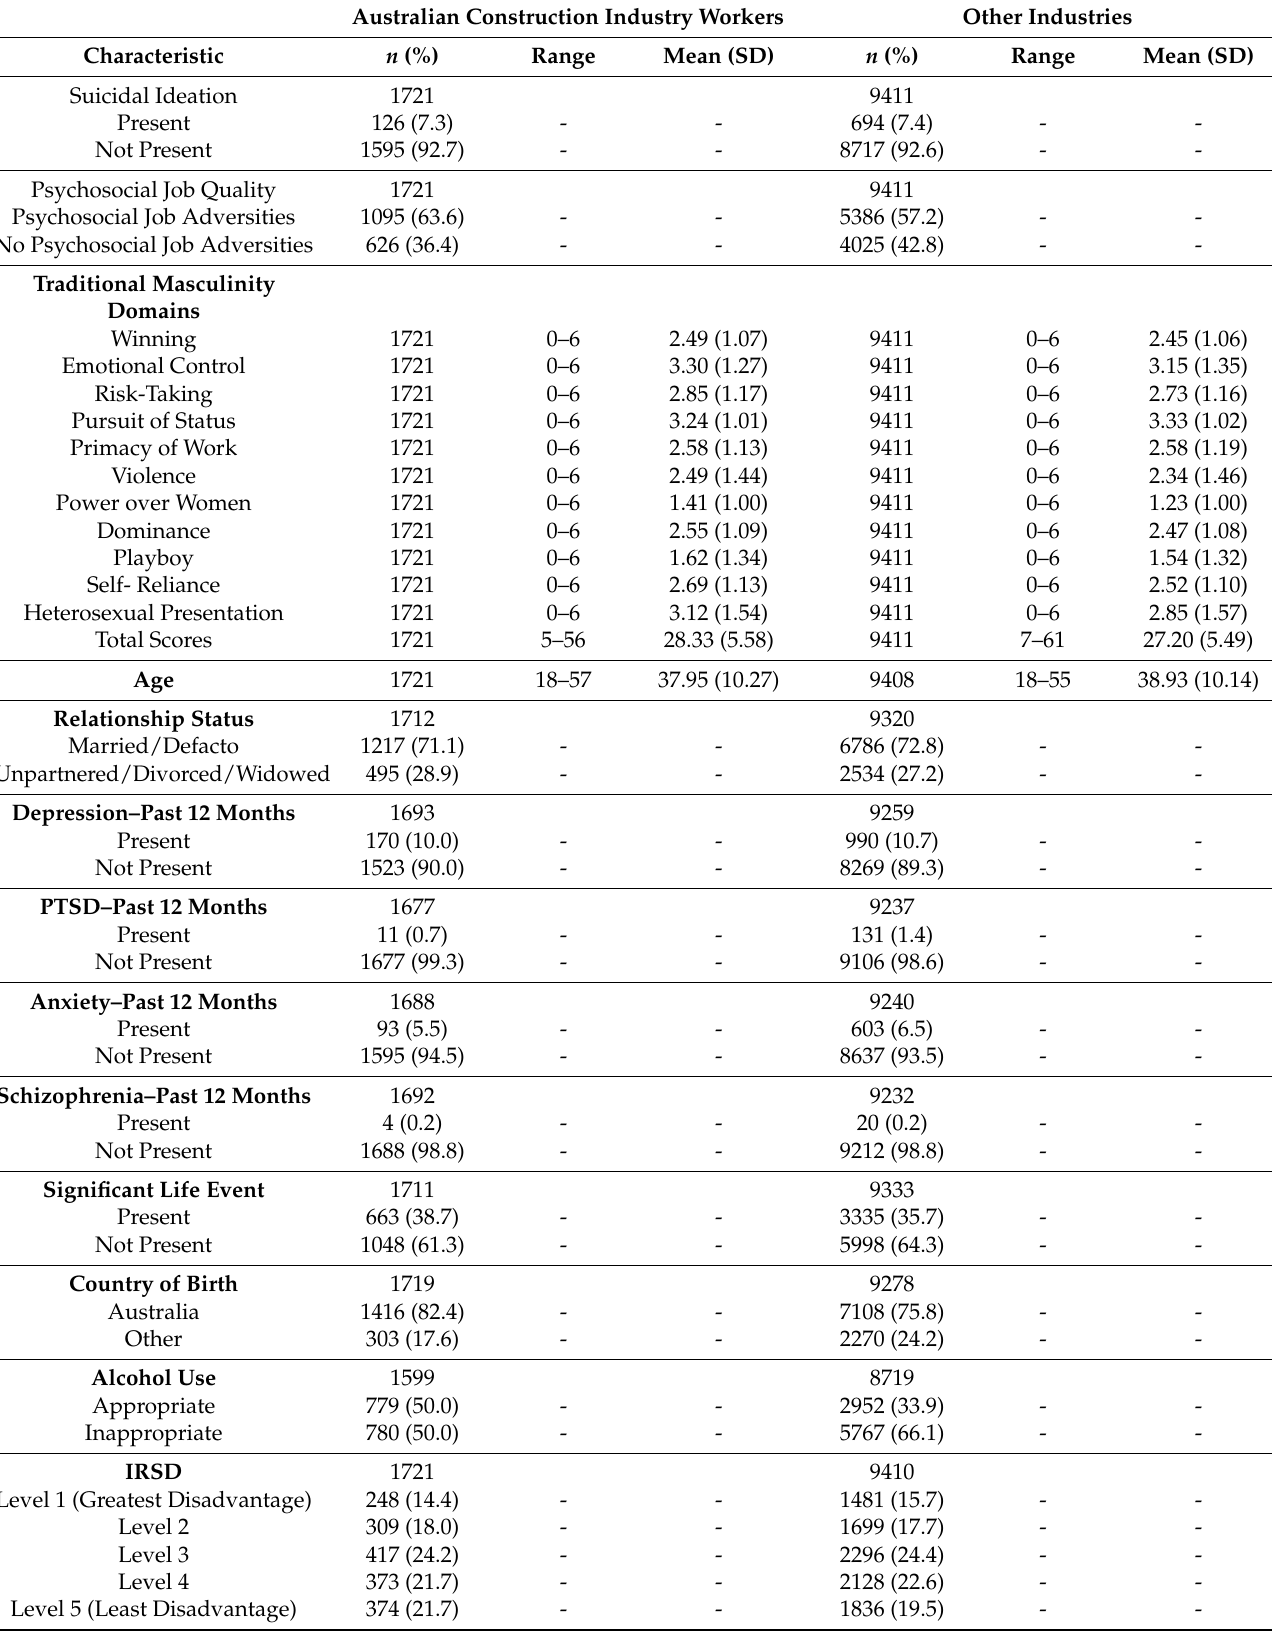
Table 1. Key Variable Characteristics of ACI and Other